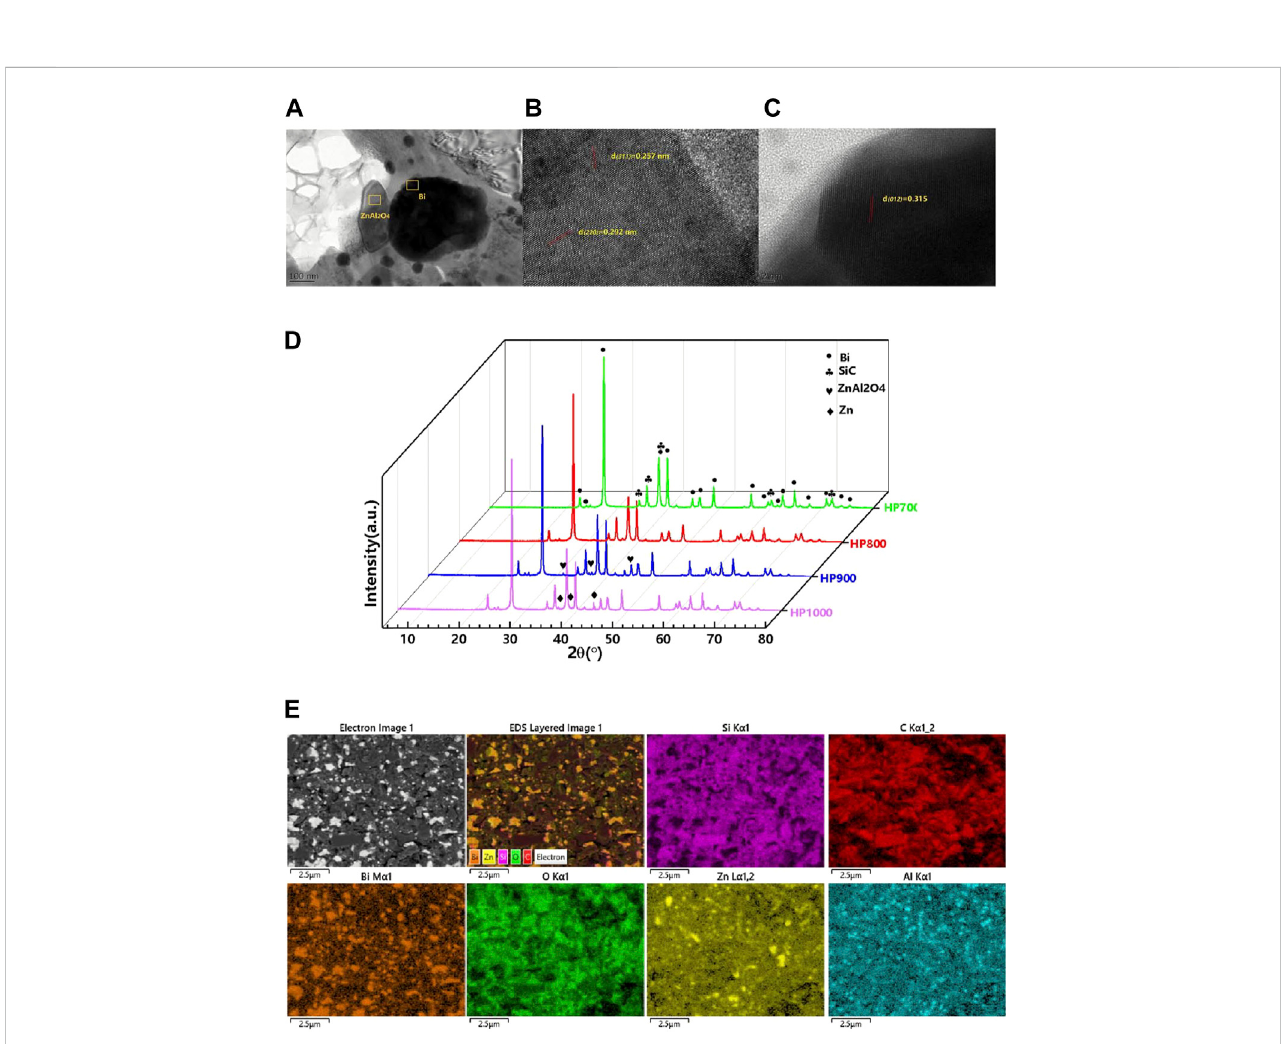
FIGURE 1 Phase composition. (A) Transmission electron microscopy (TEM) image of the SiC/BBSZA composites sintered at 900 ° C. (B) High-resolution TEM (HRTEM)imageofZnAl 2 O 4 .Thed-spacingof.257 nmand.292 nmcorrespondtothed(311)andd(220)ofZnAl 2 O 4 . (C) High-resolutionTEM(HRTEM)image of Bi. The d-spacing of .315 nm corresponds to d (012) of Bi. (D) X-ray diffraction (XRD) patterns of SiC/BBSZA composites sintered at 700 ° C, 800 ° C, 900 ° C, and 1,000 ° C, respectively. (E) EDS images of